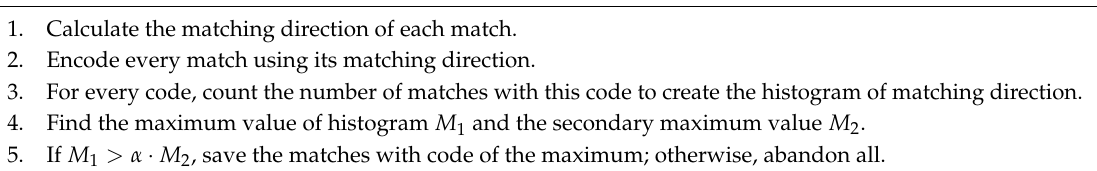
Algorithm 2. Mismatch Elimination Based on Matching